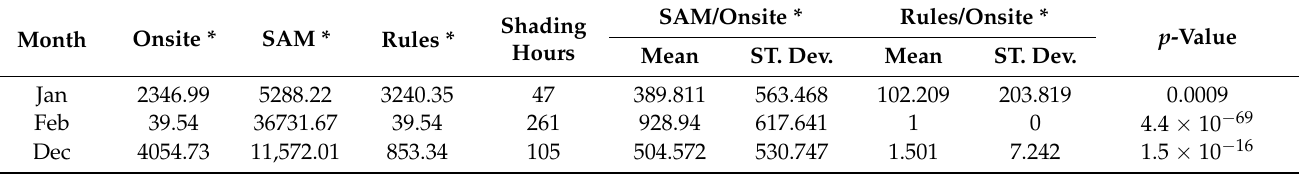
Table 7. T-test results for the application of rules (MPPT-On results), SAM estimations, and onsite measures of total hourly power productions for the case